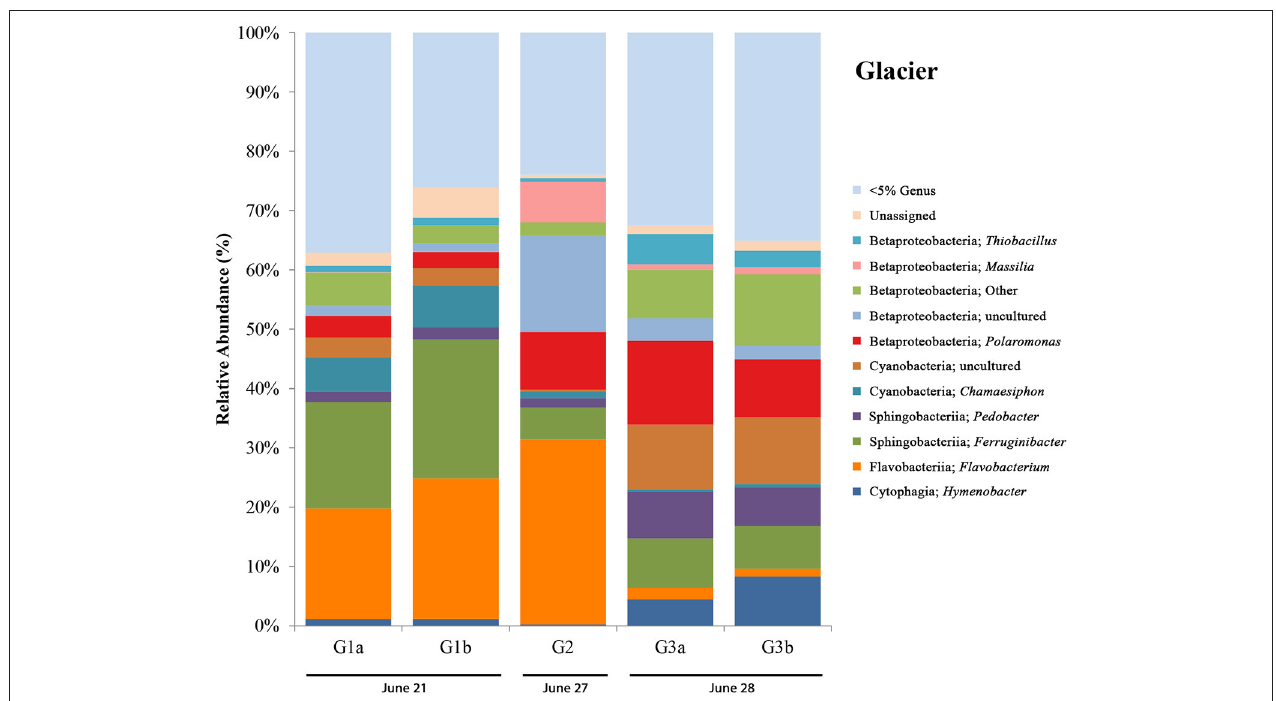
FIGURE 6 | Glacier bar charts show only OTUs that are represented above 5% in any given sample. Sites are ordered (from left to right) according to sampling date. G1-G3 only include those control sites where DNA was extracted for 16S rRNA sequencing. Only site G2 also has aqueous geochemistry data associated with it. Locations for glacier sites can be seen in Figure 1B